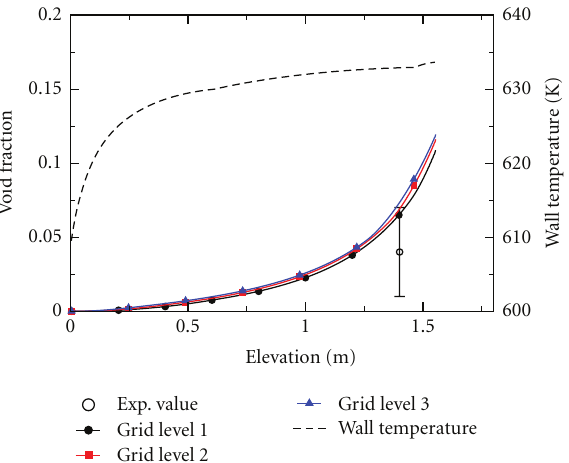
Figure 7: Run 1.2237. Axial evolution of the cross-section averaged void fraction for the 3 grid